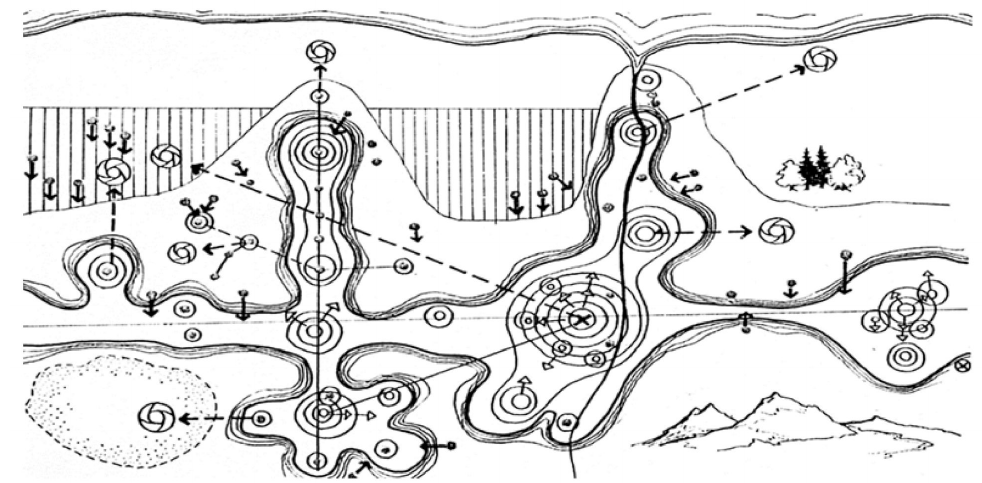
Figure 3. Fragment of the “kinetic settlement system”, according to A. Ikonnikov, K. Pchelnikov, A. Panin, etc.